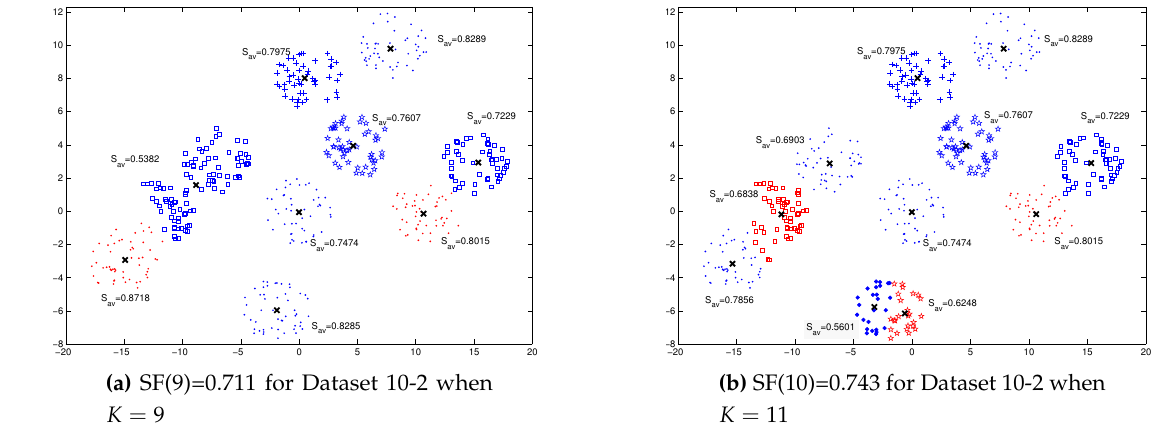
Figure 4. The cluster silhouettes for Dataset 10-2 to determine clusters must be split or merge for Dataset